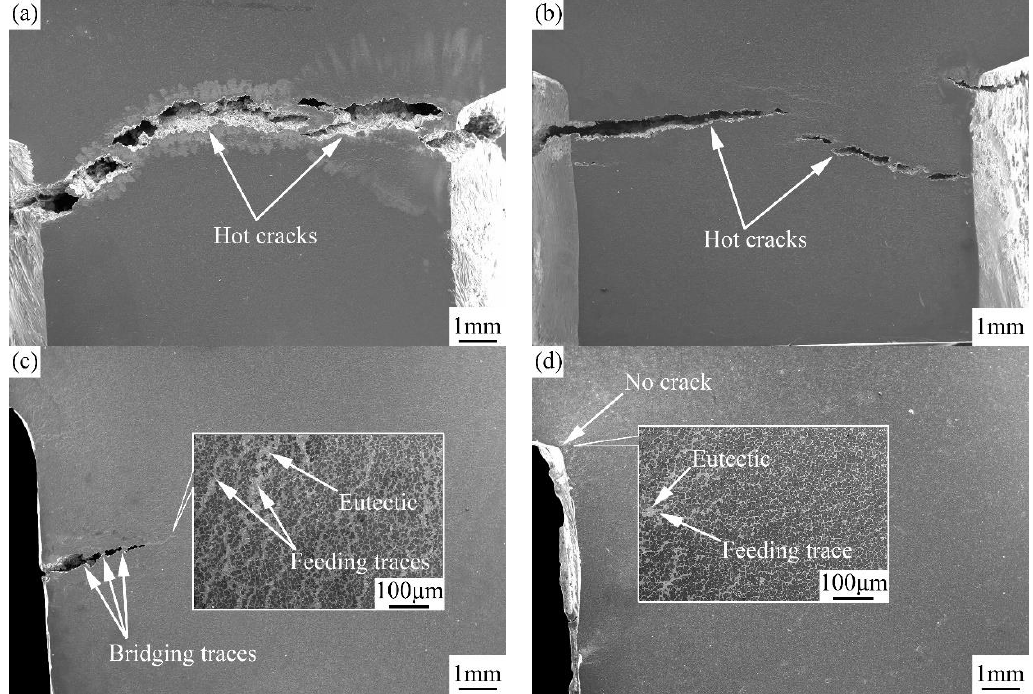
Figure 11. Micrographs of hot tears near T-junction of Mg–7Gd–5Y– x Zn–0.5Zr alloys: ( a ) x = 0 wt%; ( b ) x = 3 wt%; ( c ) x = 5 wt%; ( d ) x = 7 wt%.